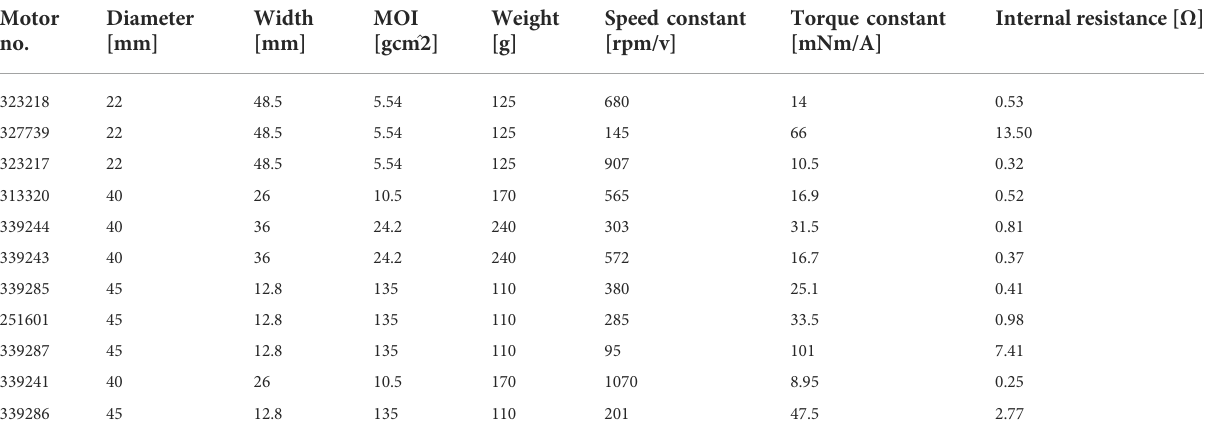
TABLE 1 Motors ’ mechanical and electrical speci fi cations. Motor